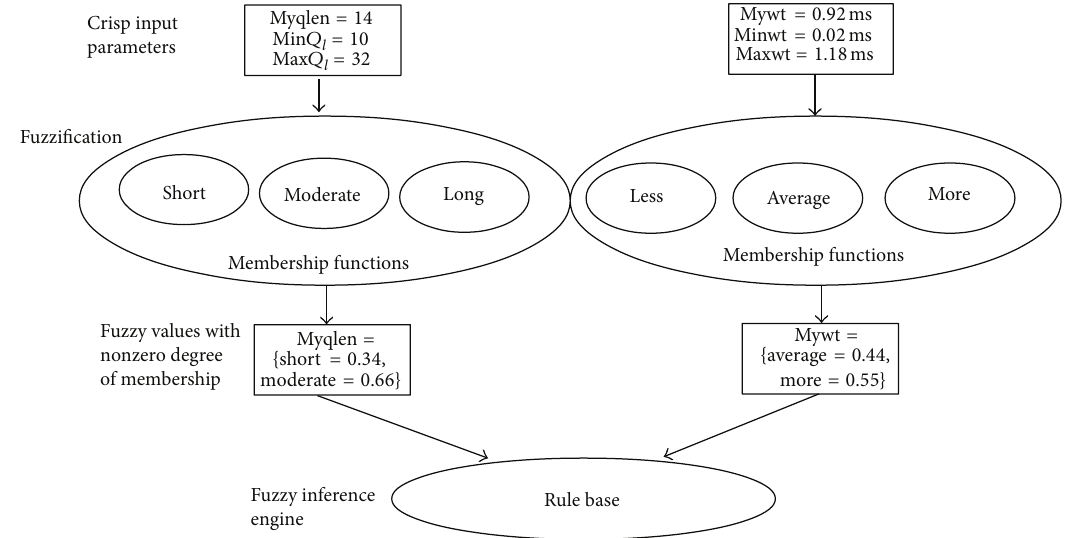
Figure 5: Input to fuzzy inference engine.